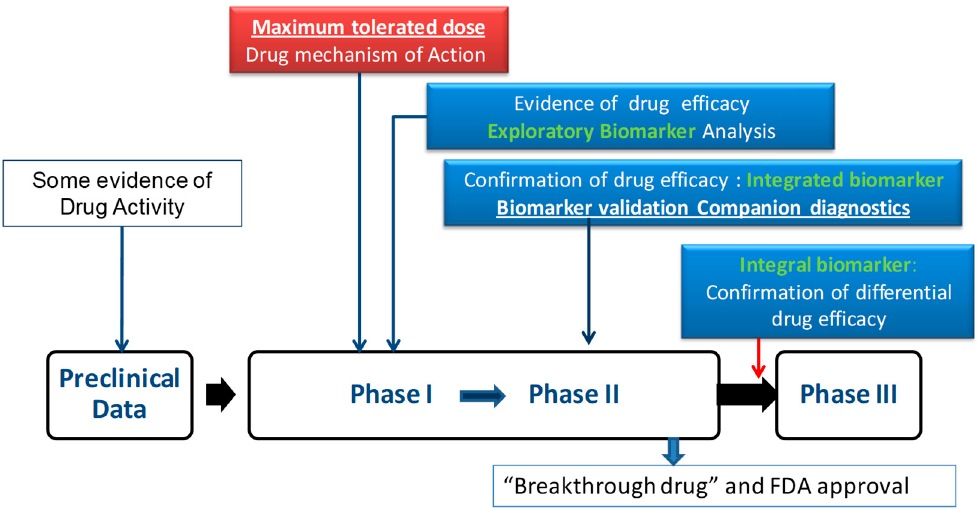
Figure 1. Paradigm for use and definition of biomarkers in clinical trials. Validation of a biomarker to be considered integral to a clinical trial from its pre-clinical definition. Slide courtesy of Dr. A. Oza from his presentation to the Gynecologic Cancer InterGroup (GCIG) Translational Research brainstorming day.